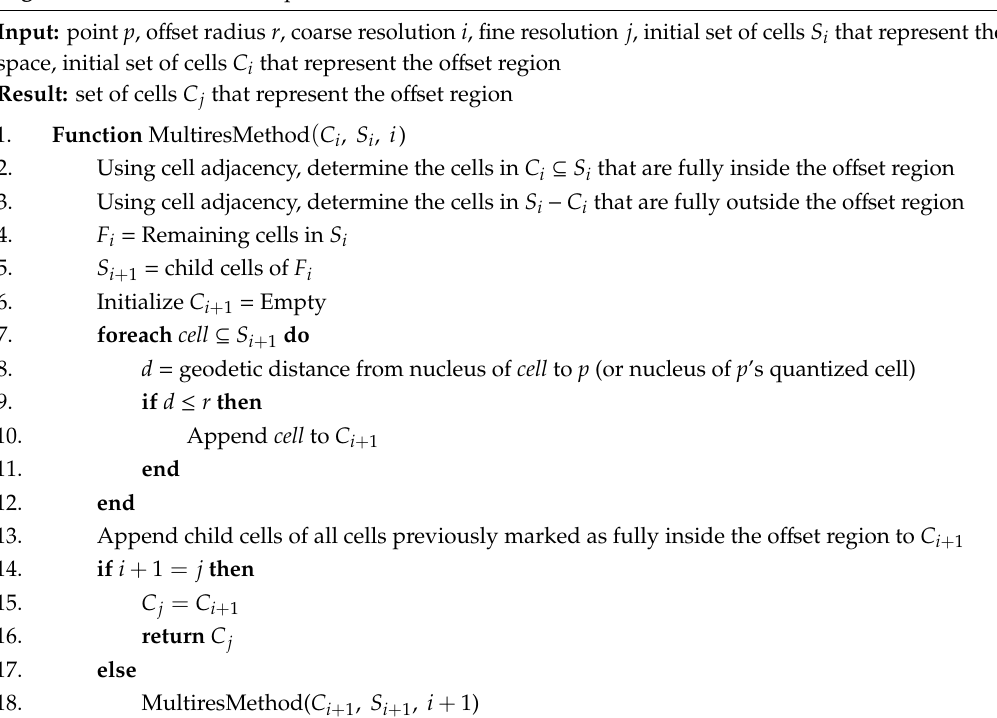
Algorithm 2 . Pseudocode to perform the multiresolution